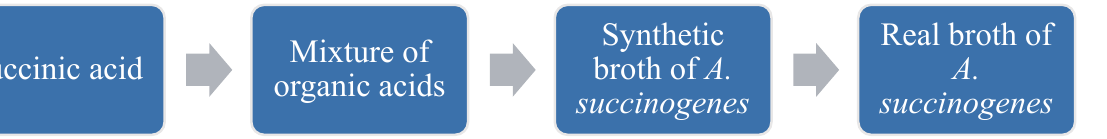
Figure 2. Simple schematic representation of four organic acid and broth solutions used in the experiments in order of time. The complexity of the solutions increases from a simple succinic acid solution to a real broth of A. succinogenes . Table 1. Qualitative composition of the different types of organic acid solutions used in the experiments. The concentrations are not indicated in this table because they varied throughout the experiments.